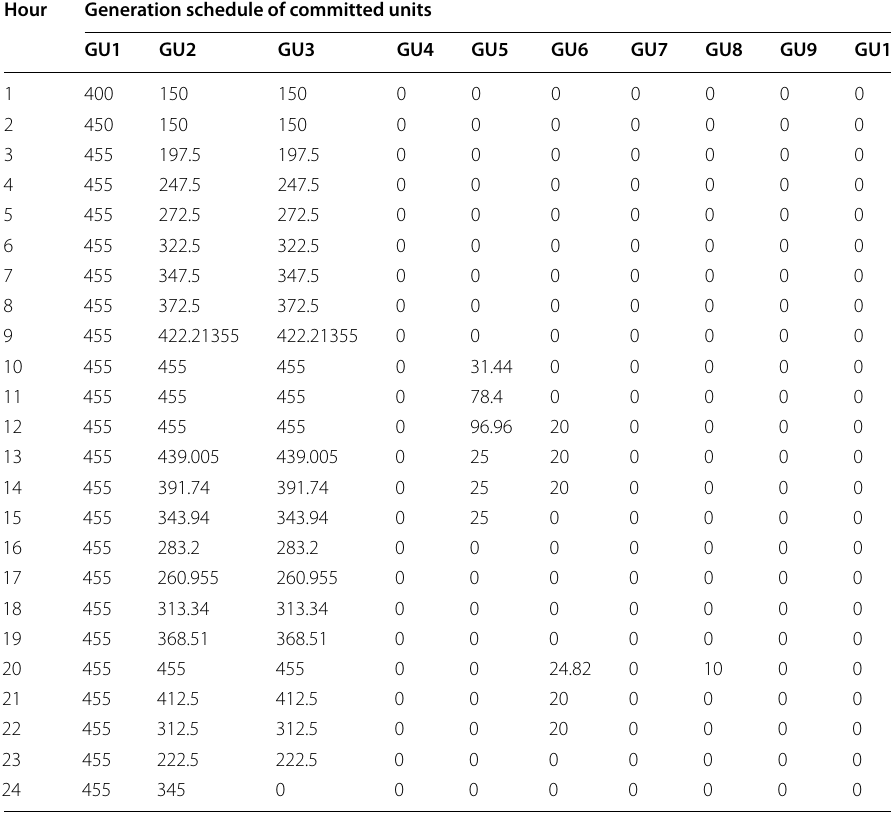
Table 14 Power scheduling for 10-generating unit system (5% SR) considering renewable energy in